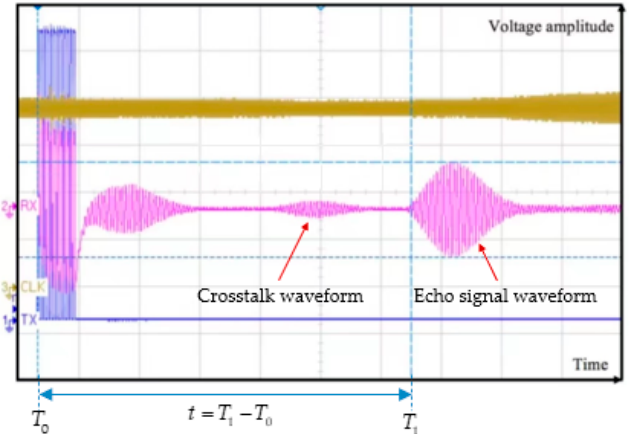
Figure 11. Driving and received signals with crosstalk (the brown line indicates the waveform of the system clock, the blue line indicates the twelve electrical pulse excitation signals and the purple line indicates the waveform of the receiver) [110]. Table 2. Performance comparison of several ATM-based ranging